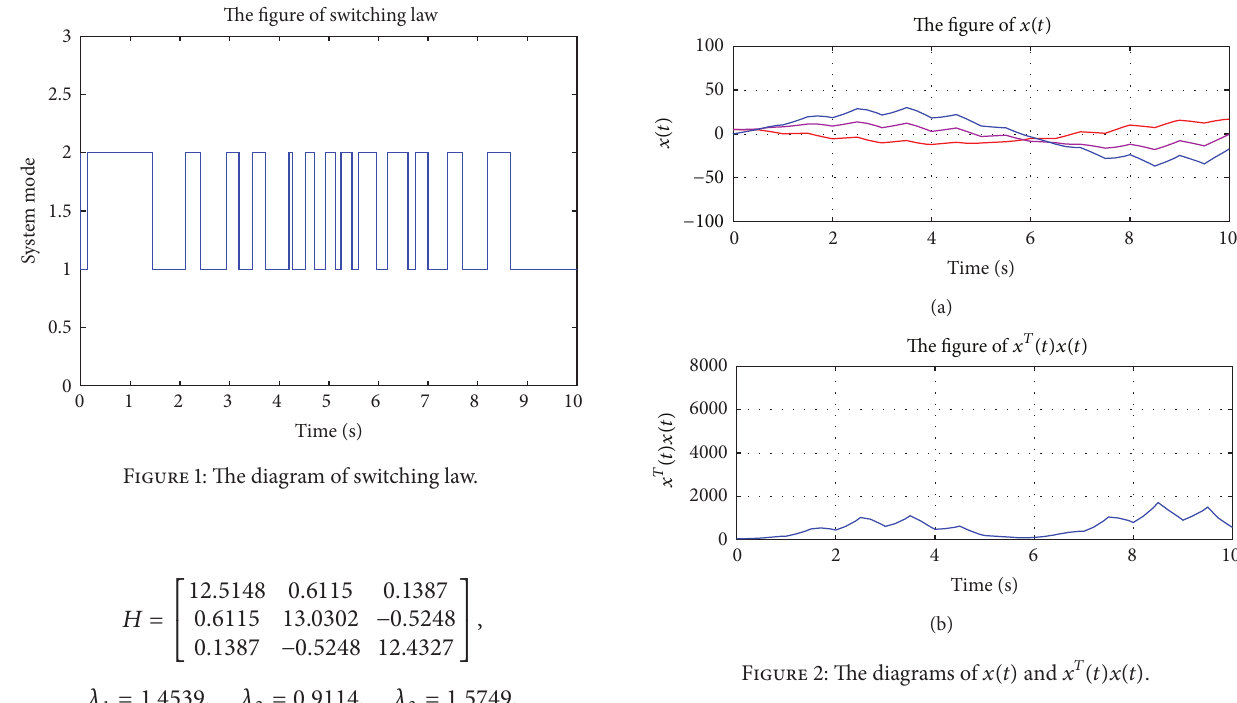
Figure 2: The diagrams of 𝑥(𝑡) and 𝑥 𝑇 (𝑡)𝑥(𝑡)